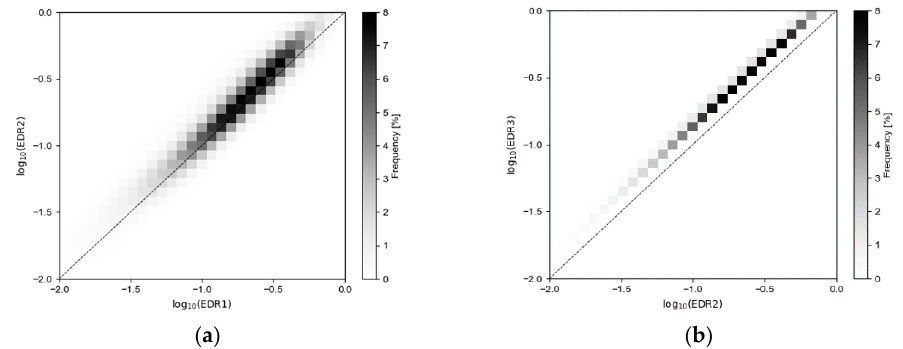
Figure 6. 2D density scatter plots between ( a ) log (cid:2869)(cid:2868) EDR1 and log (cid:2869)(cid:2868) EDR2 , and ( b ) log (cid:2869)(cid:2868) EDR2 and log (cid:2869)(cid:2868) EDR3 , calculated from the EDRs at the four levels in 2018. Bins with darker color indicate that more elements were counted within these bins.